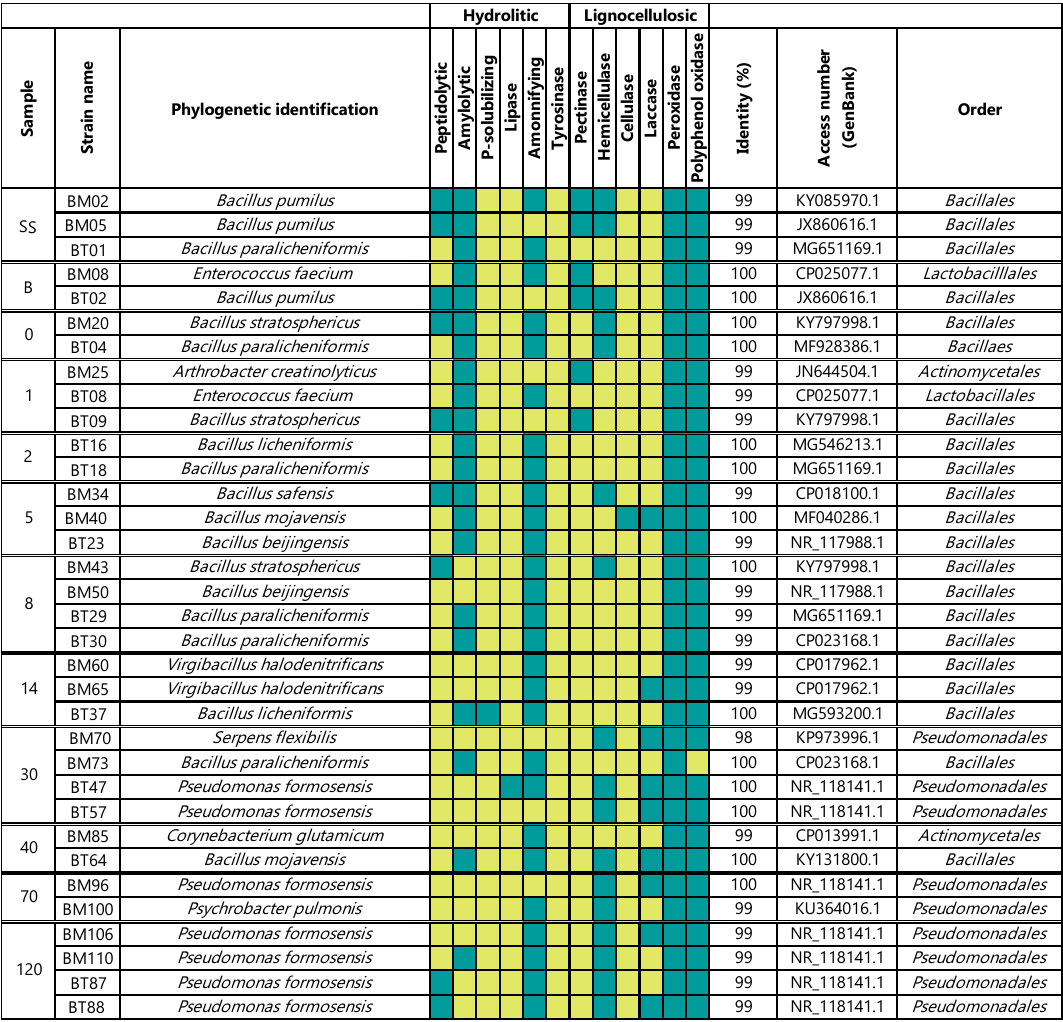
Figure 4. Heat map of the bacterial isolates identified and the extracellular profile production for each isolate (blue: positive, yellow: negative). Identity (%): Percentage of nucleotide identity with the most similar GenBank sequence (Access. number (GenBank)) and order to which each sequence belongs.